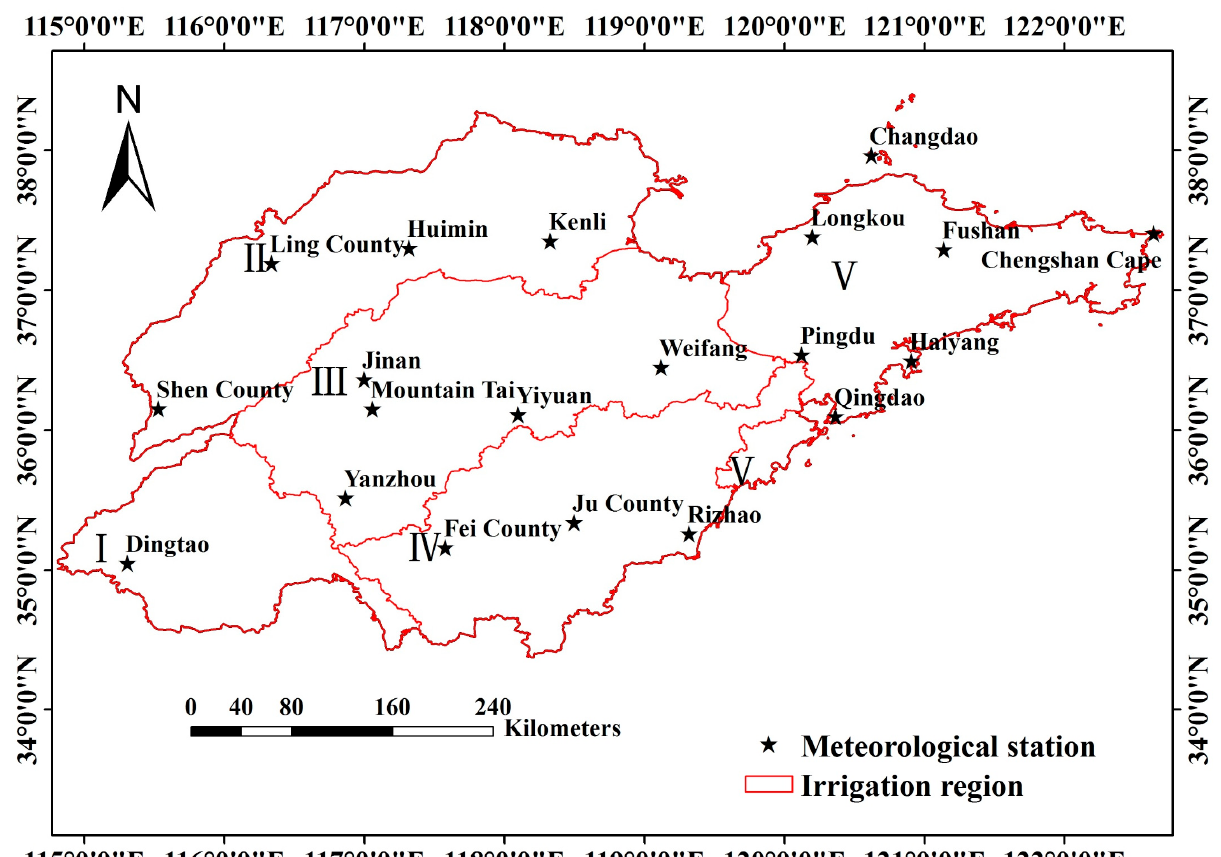
Figure 1. The distribution of meteorological stations in the irrigation regions of Shandong Province.